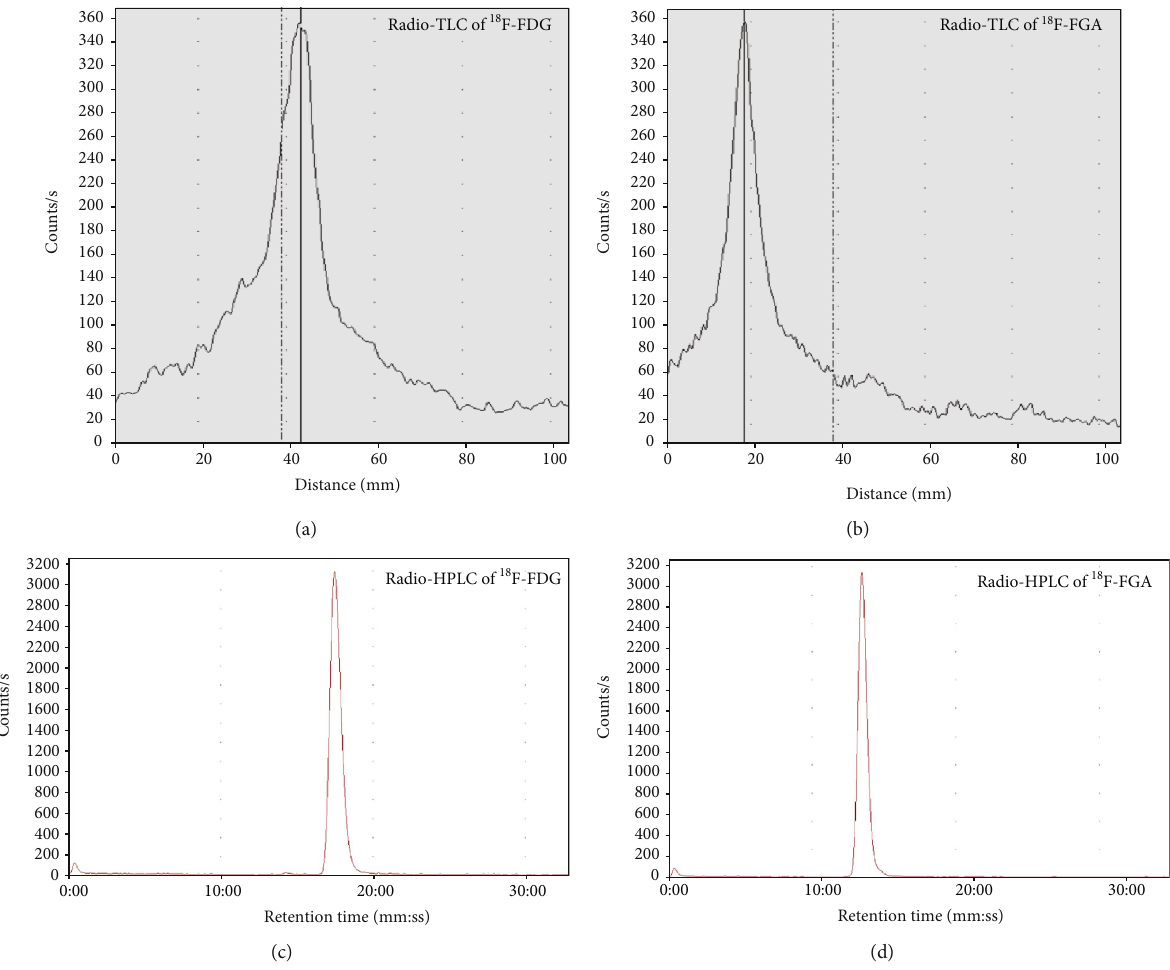
Figure 1: Quality control of 18 F-FGA. (a) and (b) are radio-TLC pro fi les of 18 F-FDG and 18 F-FGA, respectively. (c) and (d) are radio-HPLC chromatograms of 18 F-FDG and 18 F-FGA,